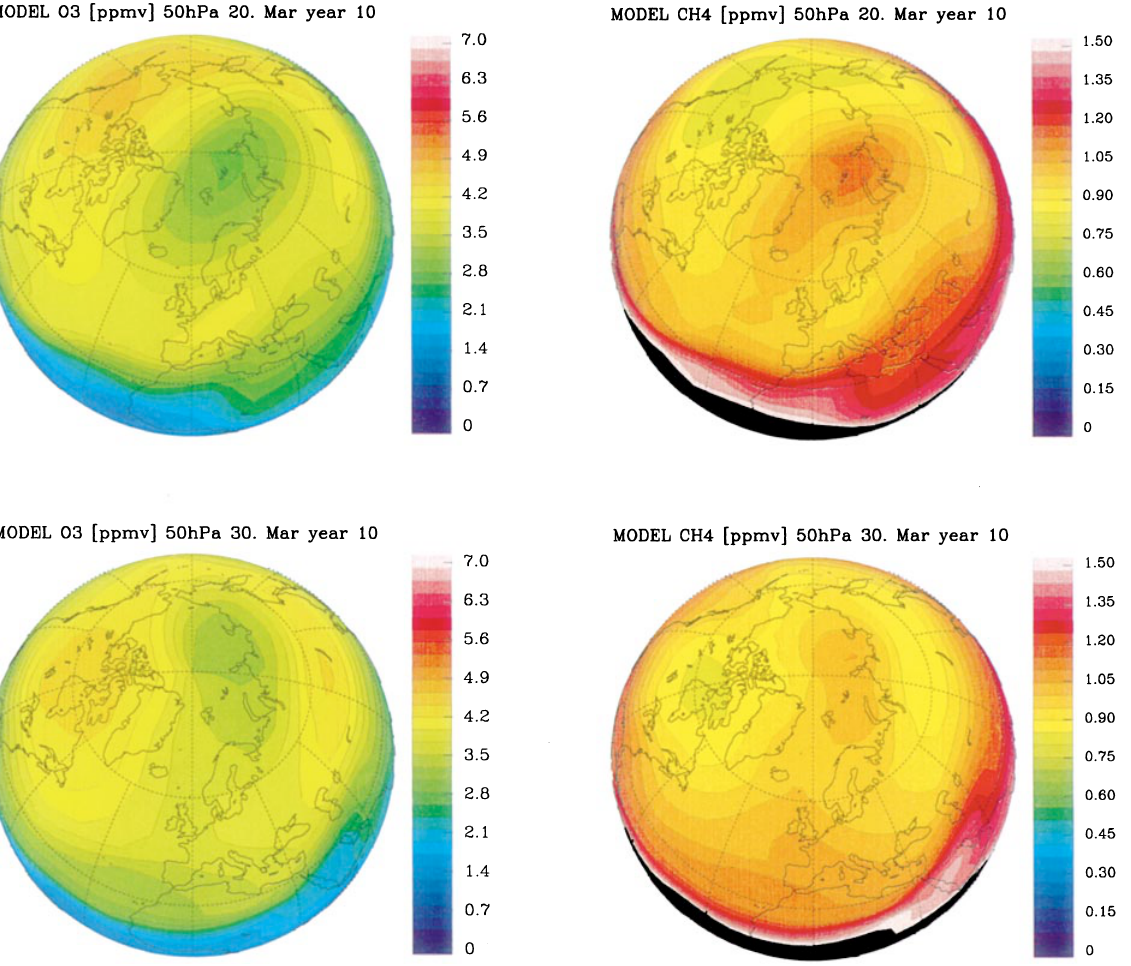
Fig. 11. Northern-hemisphere charts of ozone ( left-hand side ) and of methane ( right-hand side ) at 50 hPa on 20 March ( top ) and 30 March ( bottom ) of model year 10 (both in ppmv). The corresponding results for 25 March of model year 10 are shown in Figs. 7 and 10 (middle